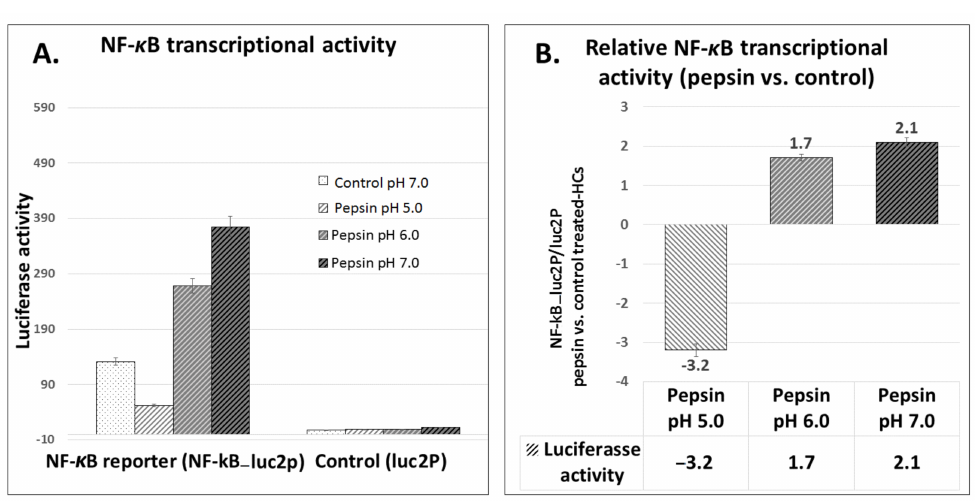
Figure 5. The effect of pepsin on NF- κ B transcriptional activity in HCs exposed at weakly acidic pH 5.0, slightly acidic pH 6.0 and neutral pH 7.0. ( A ) Columns represent luciferase NF- κ B tran- scriptional activity (mean ± SD of two independent experiments) in HCs transfected with NF- κ B luciferase responsive element (NF- κ B_Luc2P) and control luciferase reporter (luc2P). ( B ) Columns represent ratios of relative luciferase NF- κ B transcriptional activity between pepsin treated groups and control (NF- κ B_Luc2P/Luc2P: NF- κ B luciferase responsive element/control luciferase reporter in pepsin vs. control